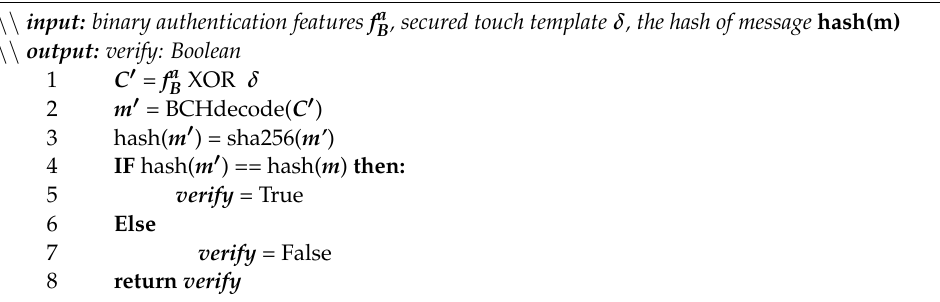
Algorithm 5 De-commit the user using their binary authentication